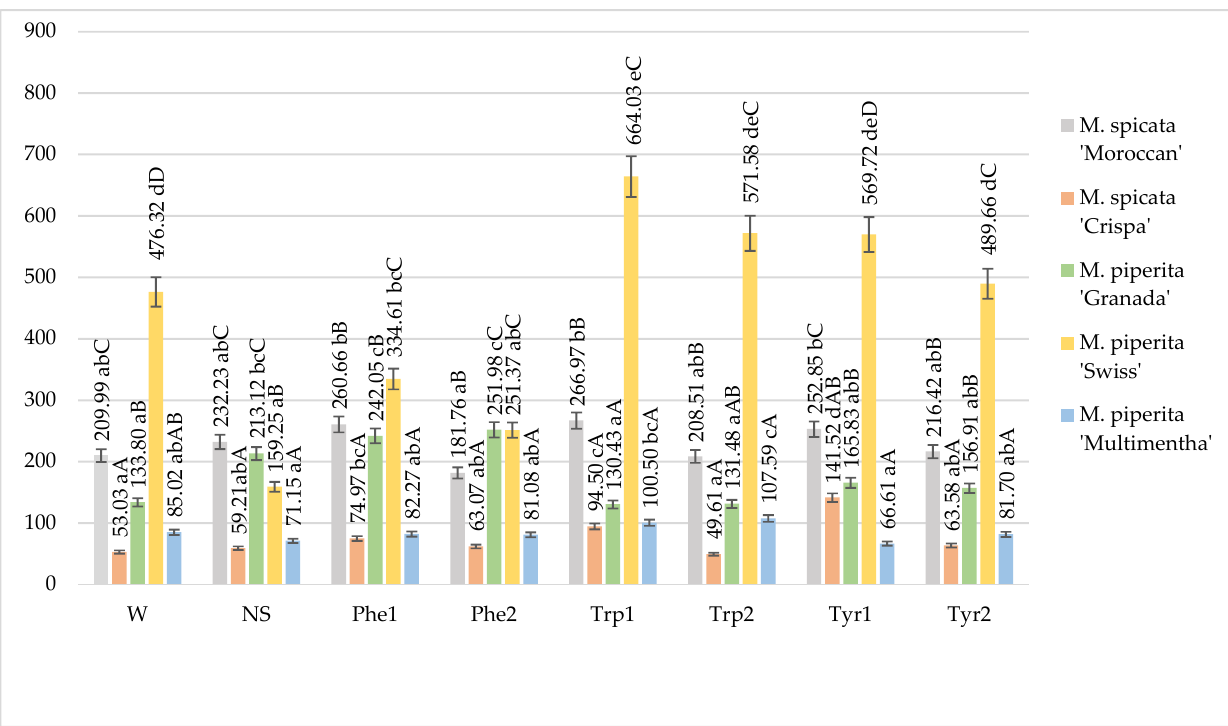
Figure 2. Total phenolic acids content in mints influenced by foliar application of amino acids, mg 100 g −1 DM in 2017–2018 (W—water, NS—non sprayed, Phe1—phenylalanine 100 mg L −1 , Phe2—phenylalanine 200 mg L −1 , Trp1—tryptophane 100 mg L −1 , Trp2—tryptophane 200 mg L −1 , Tyr1—tyrosine 100 mg L −1 , Tyr2—tyrosine 200 mg L −1 ; Means marked with different upper letters (A, B, C…) indicate significant difference between varieties at p < 0.05; Means marked with different lower letters (a, b, c…) indicate significant difference between foliar application with amino acids at p < 0.05).